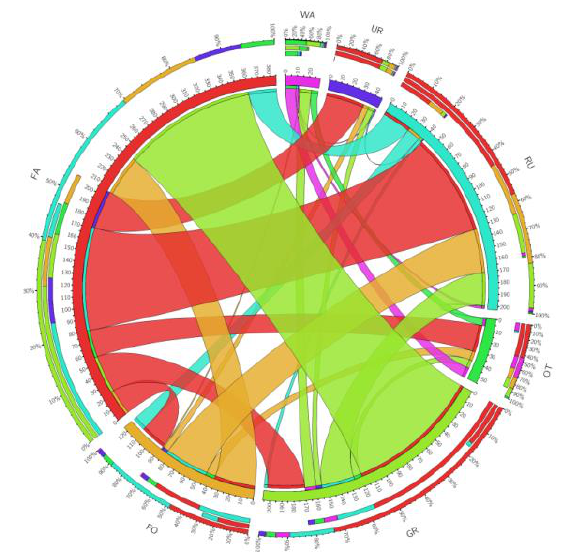
Figure 3. Land use transfer from 2010 to 2017. Notes: FA refers to farmland. FO is forest. GR